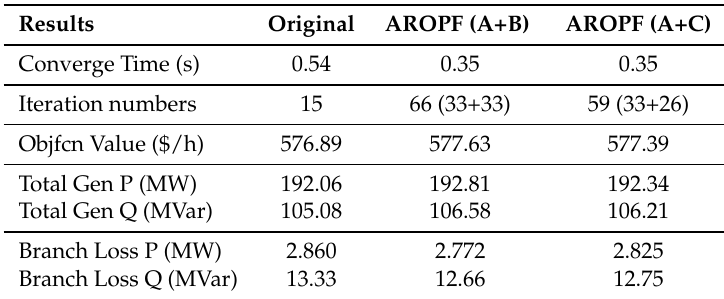
Table 4. Case 30 time cost and optimization results.